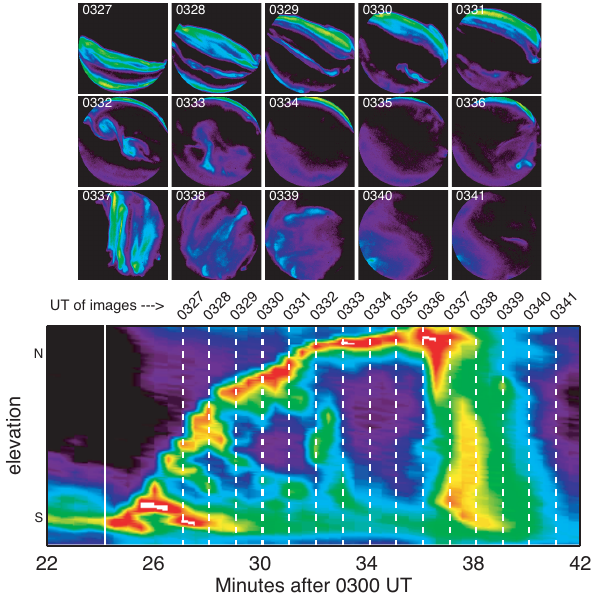
Fig. 4. A series of GIL ASI images during the substorm with one minute imaging interval (upper panel) and the MSP recordings of the green (557.7 nm) emission line (lower panel) as a function of the zenith angle and UT. Image times are marked on the MSP data by the white dashed lines, and the solid vertical line shows the time of the initial brightening at 03:24 UT.